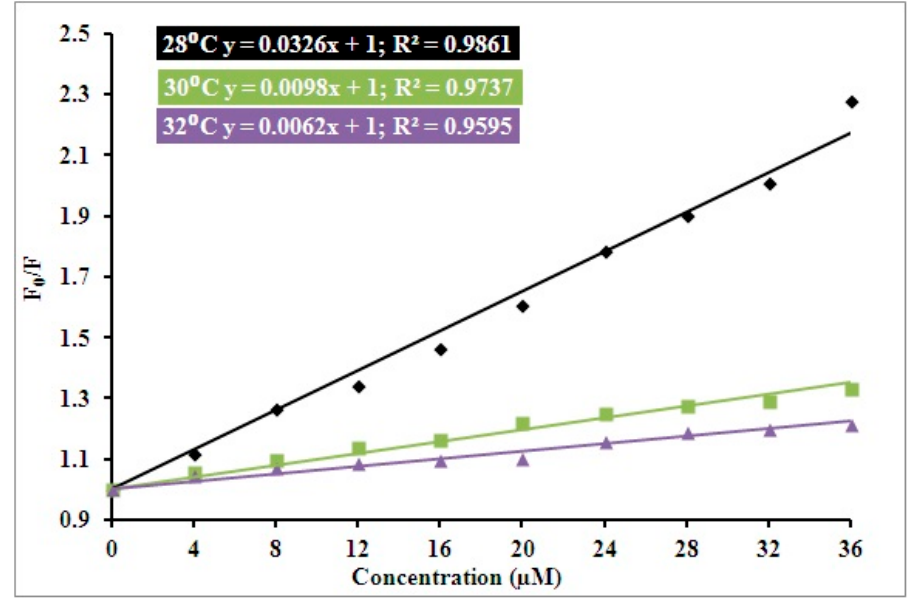
Figure 1. A plot of F 0 / F vs. [ C ] (Stern–Volmer plot) as a function of three different temperatures: The three temperatures in consideration are 301, 303, and 305 K.